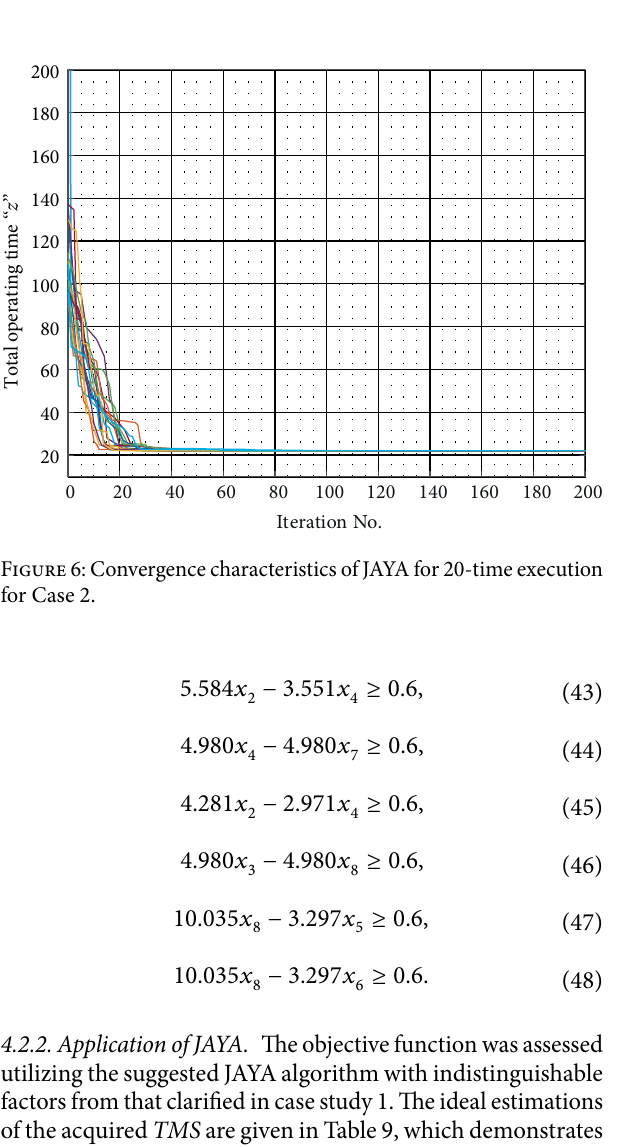
- Indicates the fault is not seen by the relay.